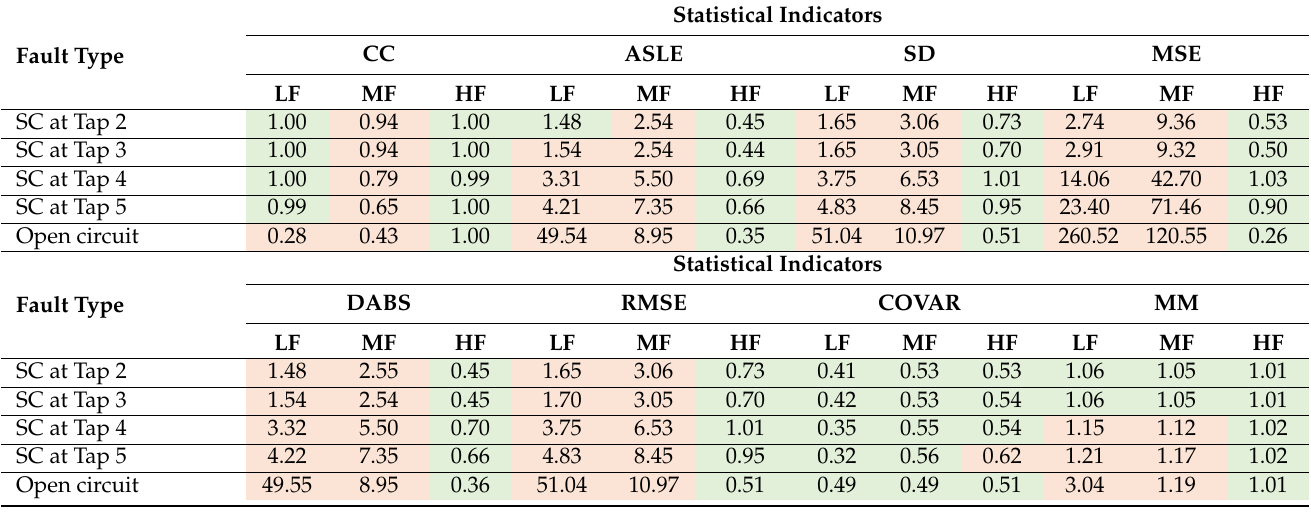
Table 7. Statistical indicators for normal and faulty FRA signatures of the tested